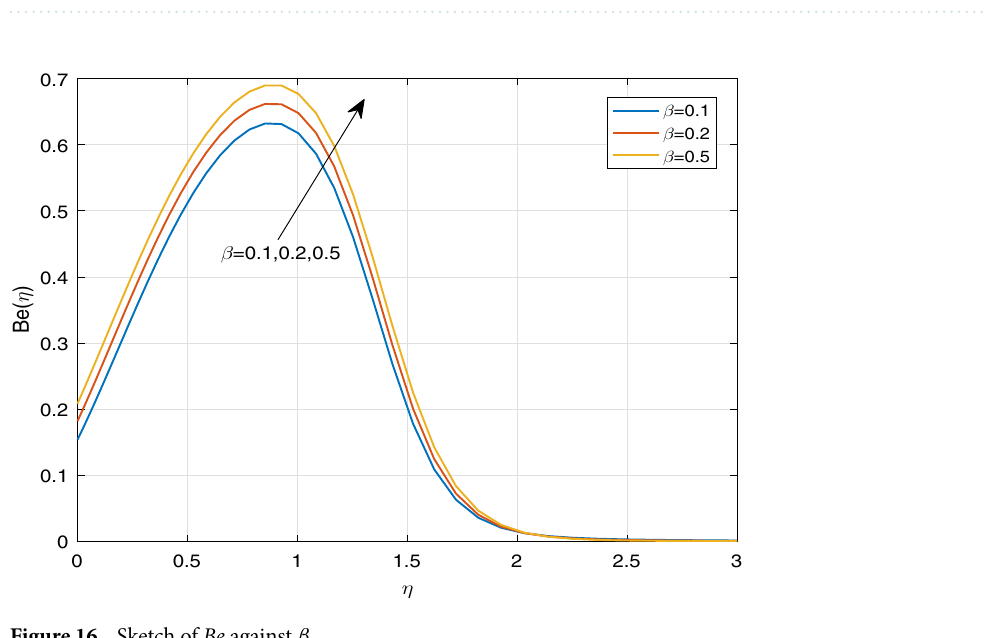
Figure 16. Sketch of Be against β